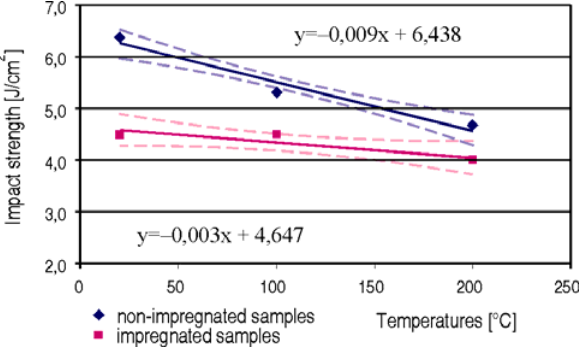
Fig 6. Tension strength vs temperature for impregnated and non-impregnated wood